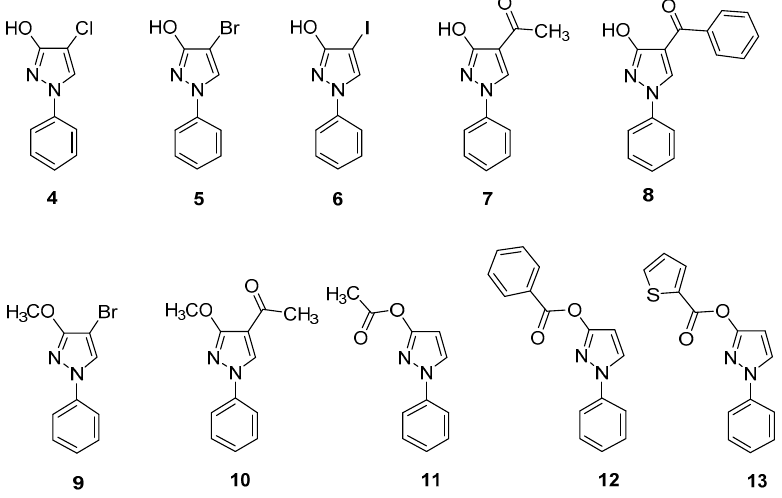
Figure 6. Investigated 4-substituted 1-phenyl-1 H -pyrazol-3-ols ( 4 – 8 ) and 3-methoxy congeners ( 9 , 10